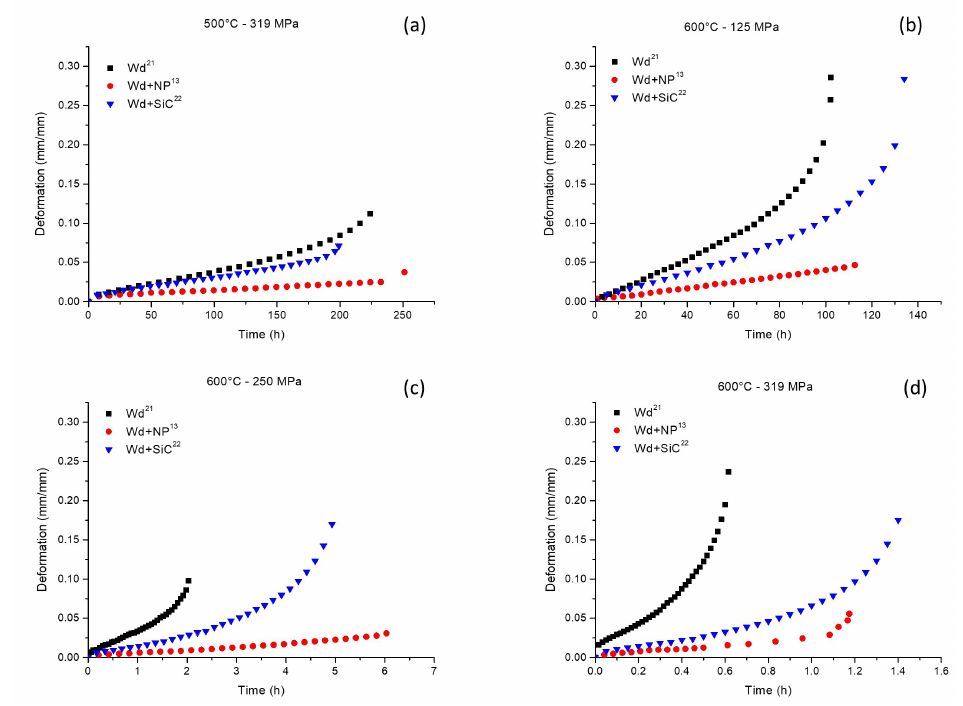
Figure 5. Ti-6Al-4V creep curves with Widmanstätten structure, untreated (Wd)21, plasma nitrided (Wd +NP) 13 and SiC coated (Wd + SiC) 22 under the conditions: (a) 500 °C and 319 MPa, (b) 600 °C and 125 MPa, (c) 600 °C and 250 MPa and (d) 600 °C and 319